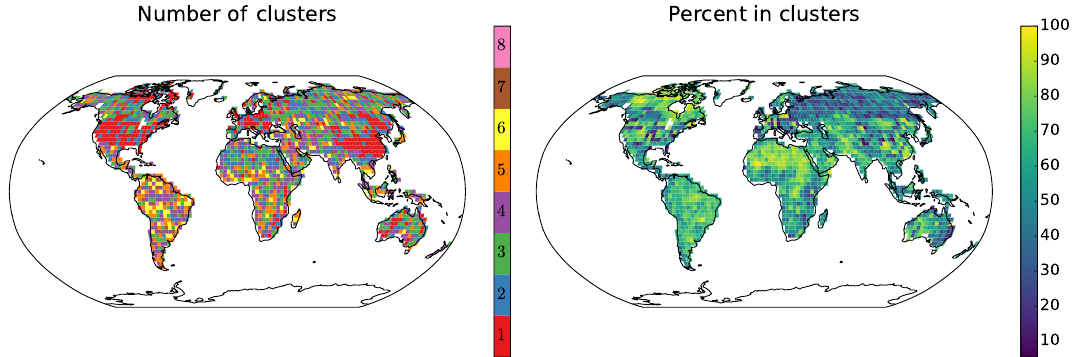
Figure 6. Global distributions of the number of clusters (tiles) found per CLASS-CTEM grid cell (left) and the percent of GSDE grid cells clustered per CLASS-CTEM grid cell